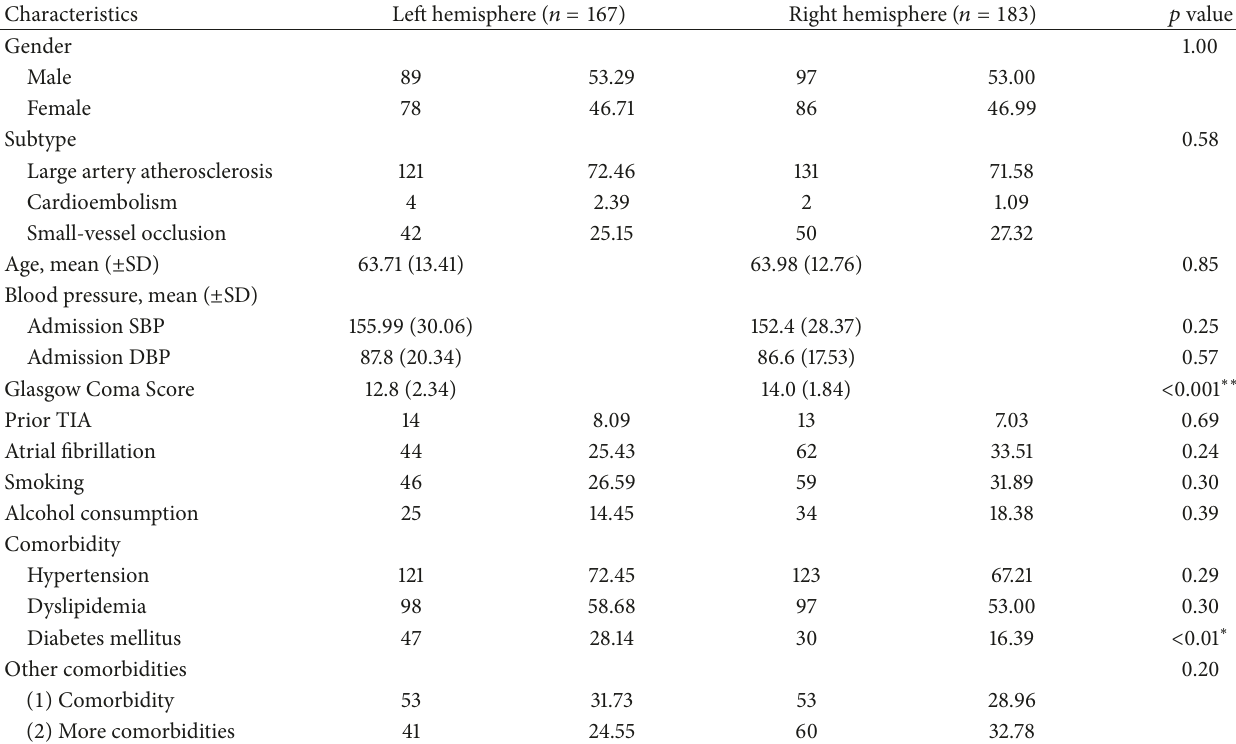
Table 1: Demographic data, premorbid health status, and stroke-related characteristics of individuals with left- and right-sided hemispheric lesion at baseline ( 𝑛 = 350 ).